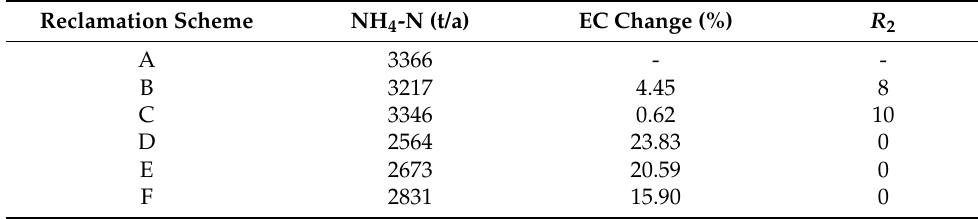
Table 13. Feasibility evaluation in NH 4 -N environmental capacity.